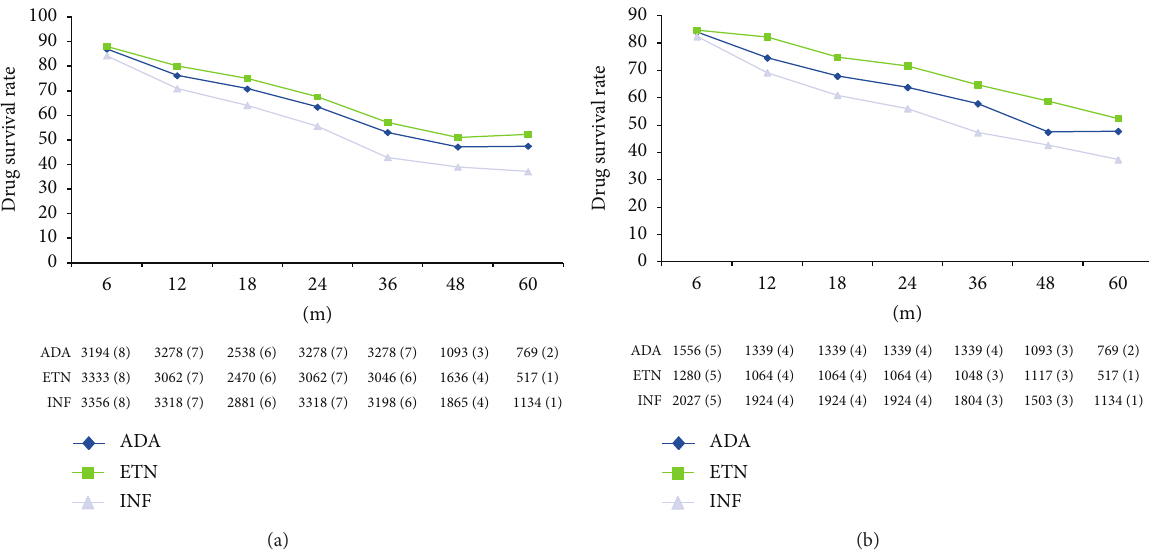
Figure 2: Drug survival rate (a). Overall group. (b) Biological na¨ıve subgroup. no. of patients (no. of contributing studies) for each time point for each anti-TNF agent reported; ADA: adalimumab; ETN: etanercept; IFN: